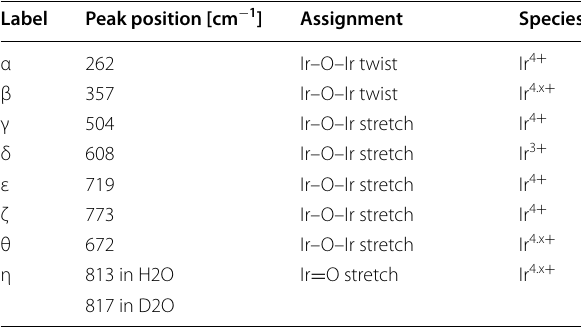
Table 2 Raman peak assignment of IrO the SHINERS technique (Fig. 9a)